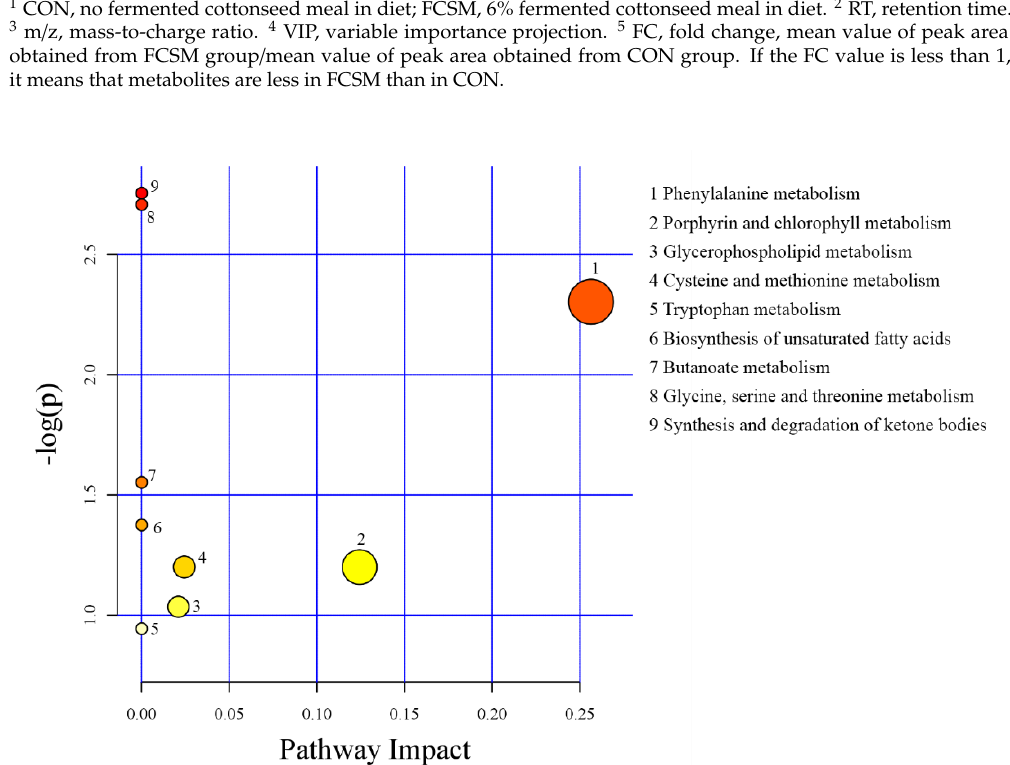
Abdominal fat was negatively associated with PPAR-α (liver gene) (r = −0.94, q = 0.005), LPL (liver gene) (r = −0.99, q = 0.005), and HSL (abdominal fat gene) (r = −0.60, q = 0.005). Subcutaneous fat thickness was negatively related to LPL-liver (r = −0.64, q = 0.038), GH-liver (r = −0.67, q = 0.035), and docosahexaenoic acid (r = −0.74, q = 0.01). Adipocyte surface was positively associated with TG-serum (r = 0.74, q = 0.037), but it was negatively associated with EPI-serum (r = −0.71, q = 0.047). 3- Hydroxybutyric acid was positively associated with HSL-liver (r = 0.69, q = 0.047), GH-liver (r = 0.69, q = 0.013), and EPI-abdominal fat (r = 0.71, q = 0.01). Azelaic acid was positively associated with TG- liver (r = 0.73, q = 0.007), while negatively associated with HSL-liver (r = −0.81, q = 0.001), LPL-liver (r = −0.62, q = 0.03), EPI-liver (r = −0.62, q = 0.03), GH-liver (r = −0.83, q = 0.001), EPI-abdominal fat (r = −0.80, q = 0.002), and GH-abdominal fat (r = −0.66, q = 0.018). Biliverdin was positively associated with HSL-liver (r = 0.69, q = 0.014) and GH-liver (r = 0.60, q = 0.038). Docosahexaenoic acid was positively associated with EPI-serum (r = 0.68, q = 0.021), GH-serum (r = 0.75, q = 0.008), HSL-liver (r = 0.63, q = 0.028), ME-liver (r = 0.59, q = 0.045), LPL-liver (r = 0.72, q = 0.008), EPI-liver (r = 0.67, q = 0.017), GH- liver (r = 0.78, q = 0.003), EPI-abdominal fat (r = 0.76, q = 0.004), GH-abdominal fat (r = 0.62, q = 0.033), PPAR-α (liver gene) (r = 0.94, q = 0.005), and LPL (liver gene) (r = 0.83, q = 0.042), while negatively associated with TG-liver (r = −0.91, q = 0.001), and Glu-serum (r = −0.70, q = 0.016) (Figure 4).